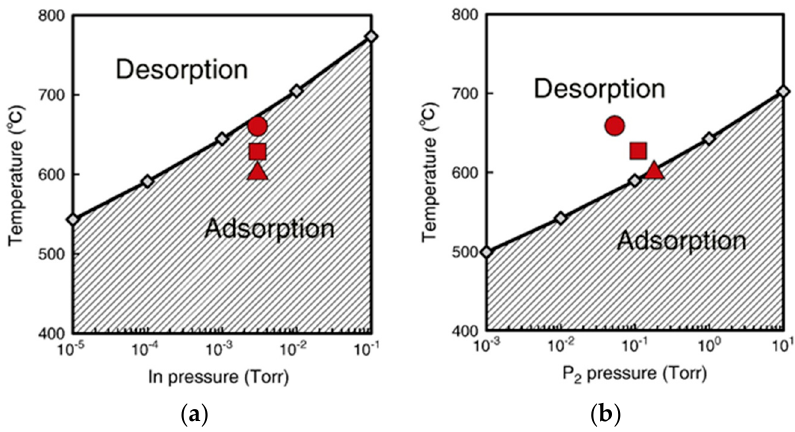
Figure 32. Calculated phase diagrams as functions of temperature and pressure on the In-adsorbed ( 1100 ) surface for adsorption of ( a ) In and ( b ) P atoms. Regions with hatched lines correspond to atom-adsorbed regions. Red circles, squares, and triangles represent the growth conditions for the high temperature and low V/III ratio, the intermediate temperature and V/III ratio, and the low temperature and high V/III ratio, respectively. In pressure is fixed at 3.3 × 10 − 3 Torr which corresponds to the experimental growth conditions [90,91]. Reprinted with permission from [99]. Copyright (2013) by Elsevier.